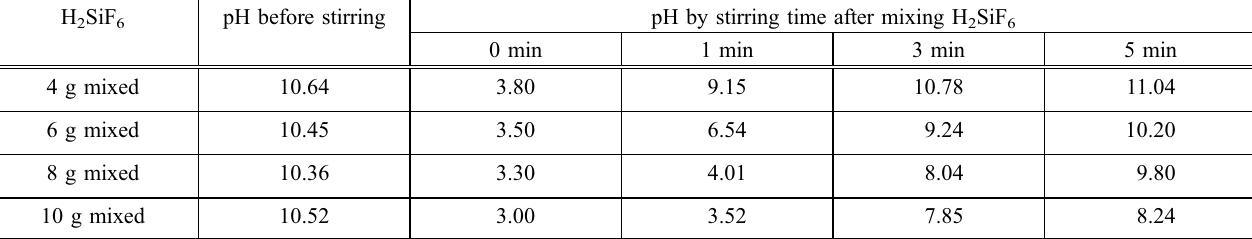
Table 9 Changes in pH pH by stirring time after mixing H 2 SiF 6